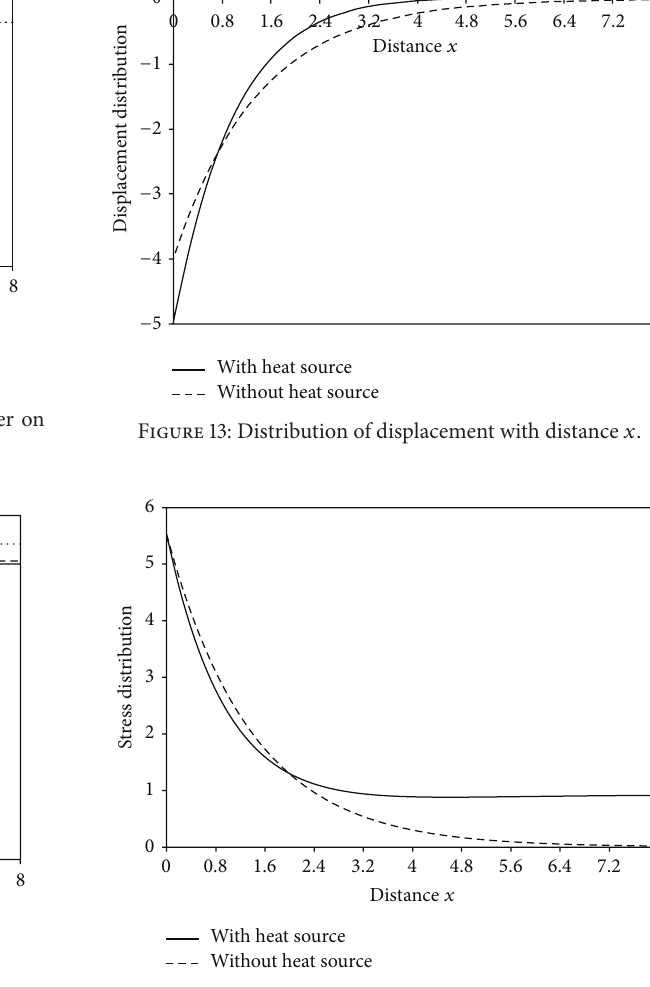
Figure 14: Distribution of stress with distance 𝑥